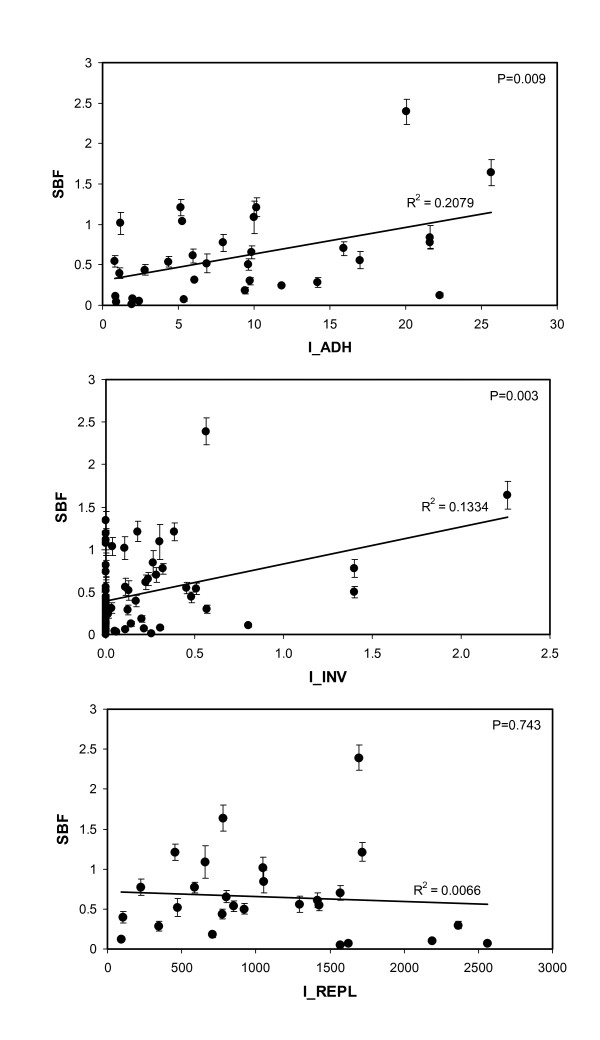
Correlations between biofilm formation and the adhesion, invasion, and intra-macrophage replication abilities of both AIEC and non-AIEC strains. Adhesion and invasion indices correlated positively with biofilm formation capacity, whereas intra-macrophage survival and replication did not. Adhesion index was calculated as: I_ADH = attached bacterial cells/intestinal cell; invasion index as: I_INV(%) = (intracellular bacteria/4×106 bacteria inoculated) × 100; and replication index as: I_REPL = (cfu ml-1 at 24 h/cfu ml-1 at 1 h)× 100.